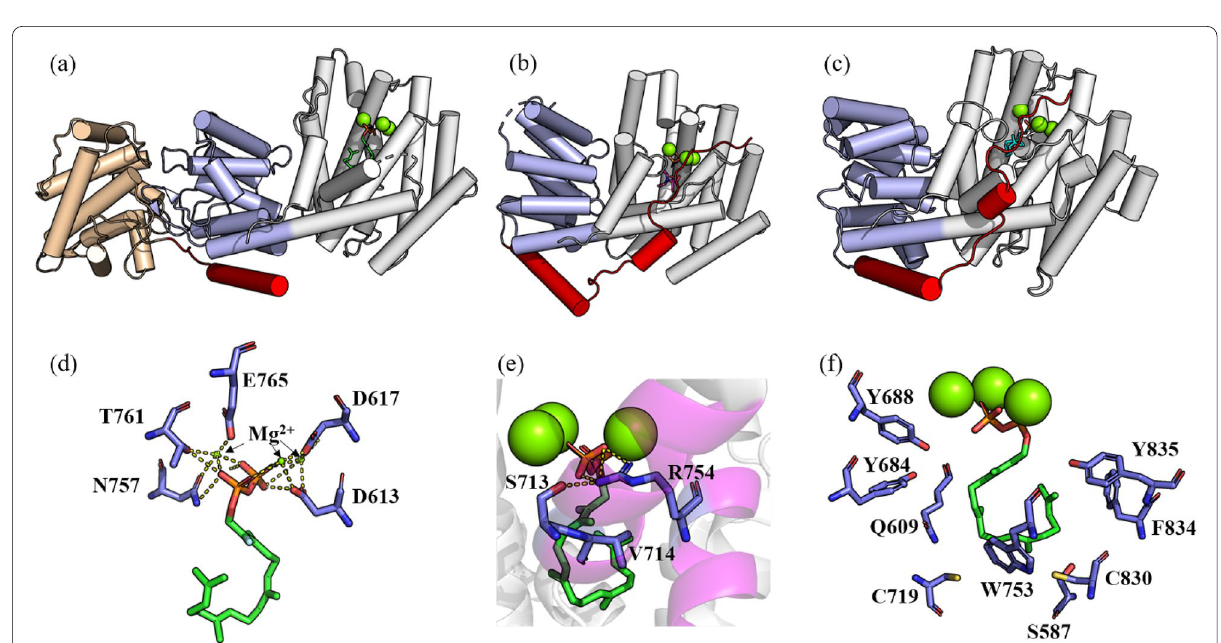
Fig. 14 a Structure of TS complexed with 2‑fluorogeranylgeranyl diphosphate and Mg 2 + (PDB ID: 3P5R). b Structure of BPPS complexed with inorganic pyrophosphate and Mg 2 + (PDB ID: 1N1Z). c Structure of EAS complexed with substrate analog farnesyl hydroxyphosphonate